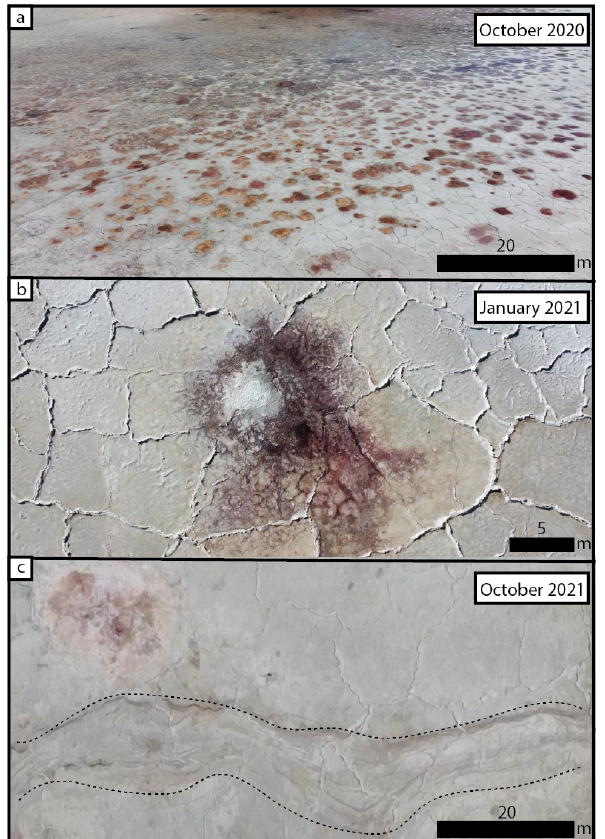
Figure 5. Large-scale features observed by drone around Deep Springs. (a) Spring mounds surrounded by polygonal fractures within Deep Springs Lake. (b) Closer view of one spring mound and polygonal fracture. (c) Edge of Deep Springs Lake showing com- pressed shorelines that are similar to those seen in Fig. 7d and f. The shoreline is indicated by bounding dashed lines. In between these dashed lines, the shoreline is filled with curvilinear features that are compressed and follow the same